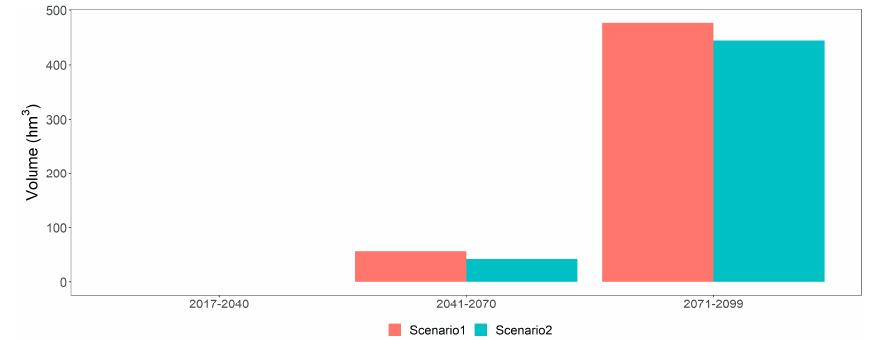
Figure 13. Annual unmet demand for Scenarios 1 and 2 for the period 1981–2099.